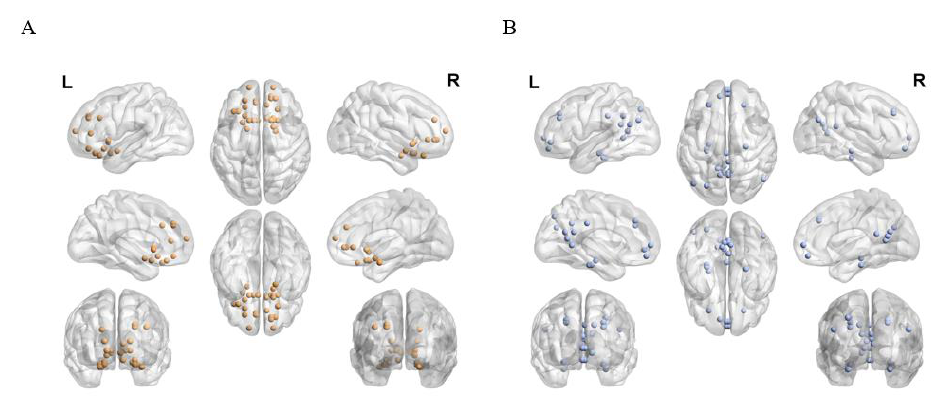
Figure 3. ( A ) A total of 31 ROIs from ON and ( B ) 37 ROIs from DMN are used for ROI-wise analysis between/within ON and DMN.